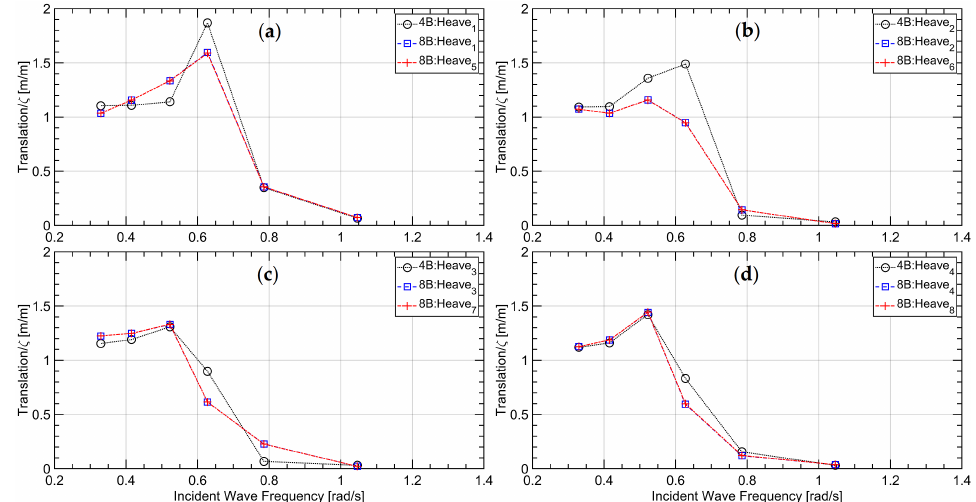
Figure 18. RAOs of heave response studying the sensitivity to module arrangement, where n B denotes the configuration with n bodies; subscript n , the corresponding n -th body’s motion response: ( a ) the 1st and 5th modules; (B) the 2nd and 6th modules; ( c ) the 3rd and 7th modules; ( d ) the 4th and 8th